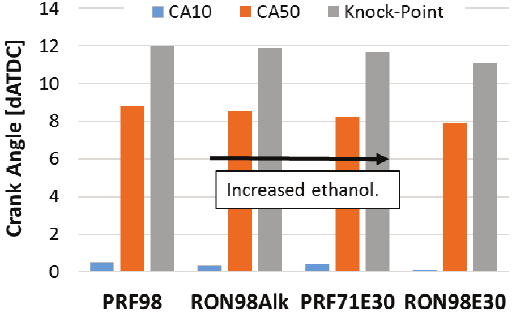
Fig. 11. Comparison of ASTM knockmeter measurement, peak pressure rise rate (PPRR), and knocking pressure peak